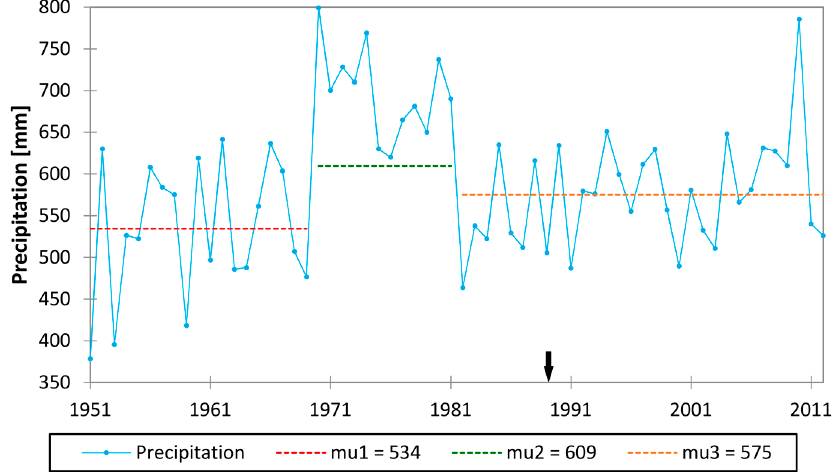
Figure 2. Total annual precipitation for the time period 1951–2012 in the Upper Narew Catchment. “mu” stands for the average value at each time period. The black arrow indicates the year the SR started operation.